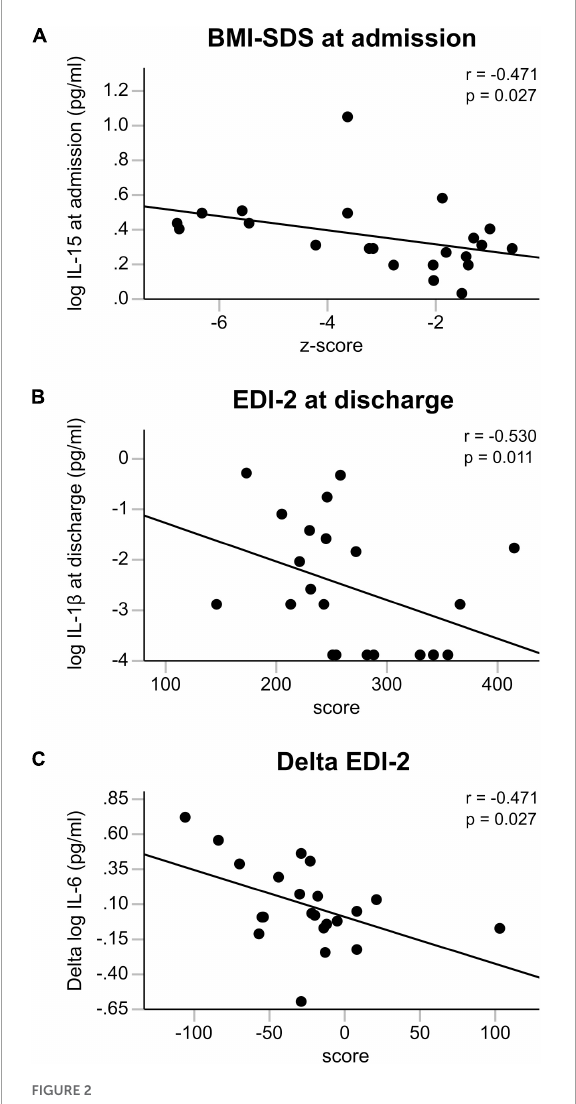
FIGURE2 (A–C) Clinical associations. Association of BMI-SDS with IL-15 at admission, of IL-1 β with EDI-2 at discharge and of the change in eating disorder psychopathology (EDI-2) with the change in IL-6 between admission and discharge all calculated with Spearman’s general correlation coefficient. All cytokine levels were log